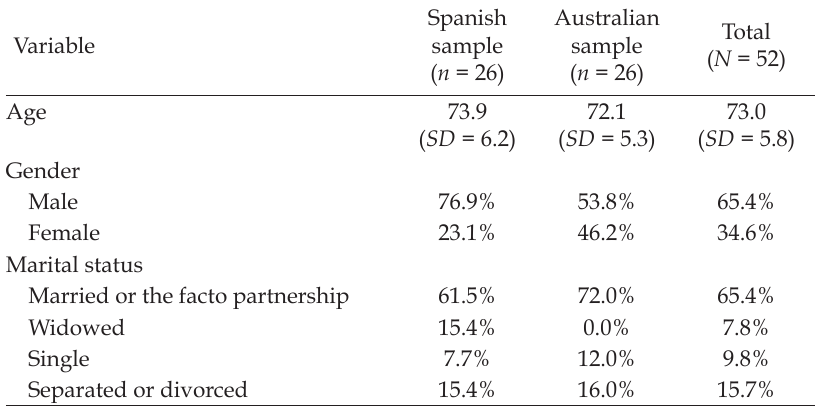
Table 1. Comparative profile of Spanish and Australian